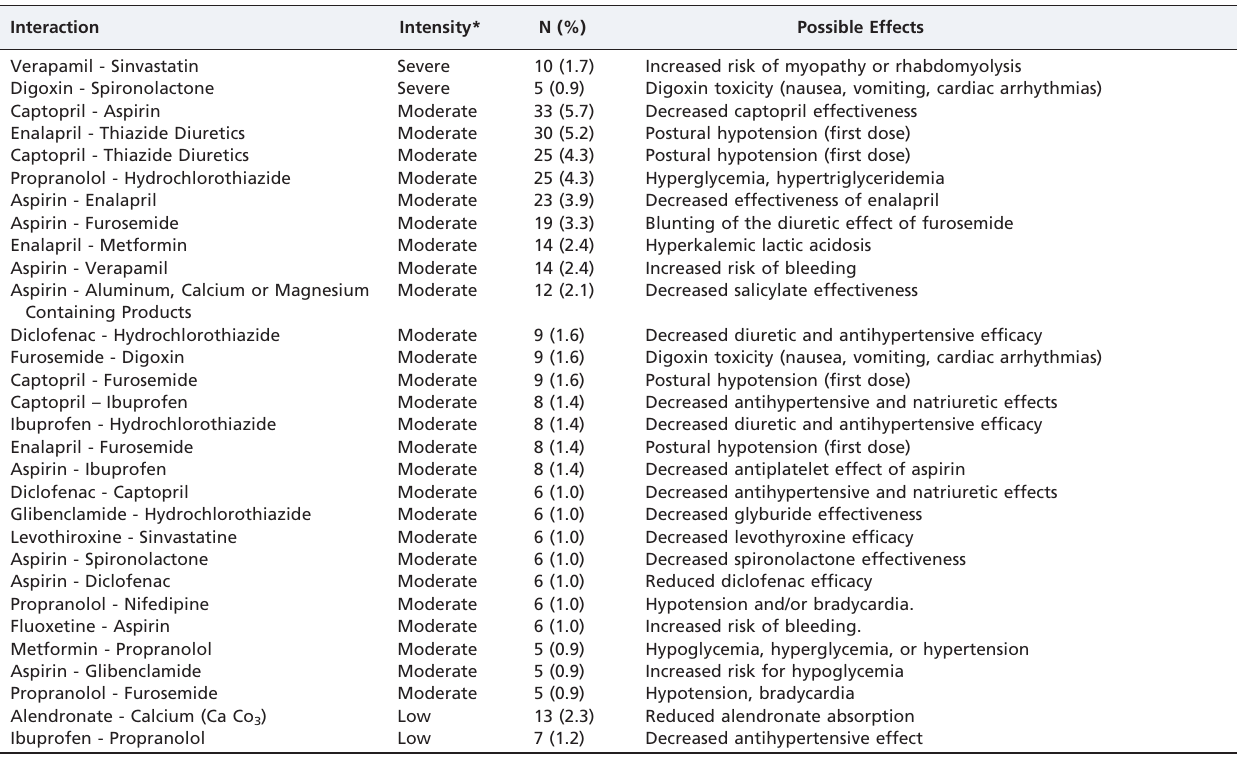
Table 2 - The 30 most frequent Drug-Drug Interactions (DDI) in the elderly. Interaction